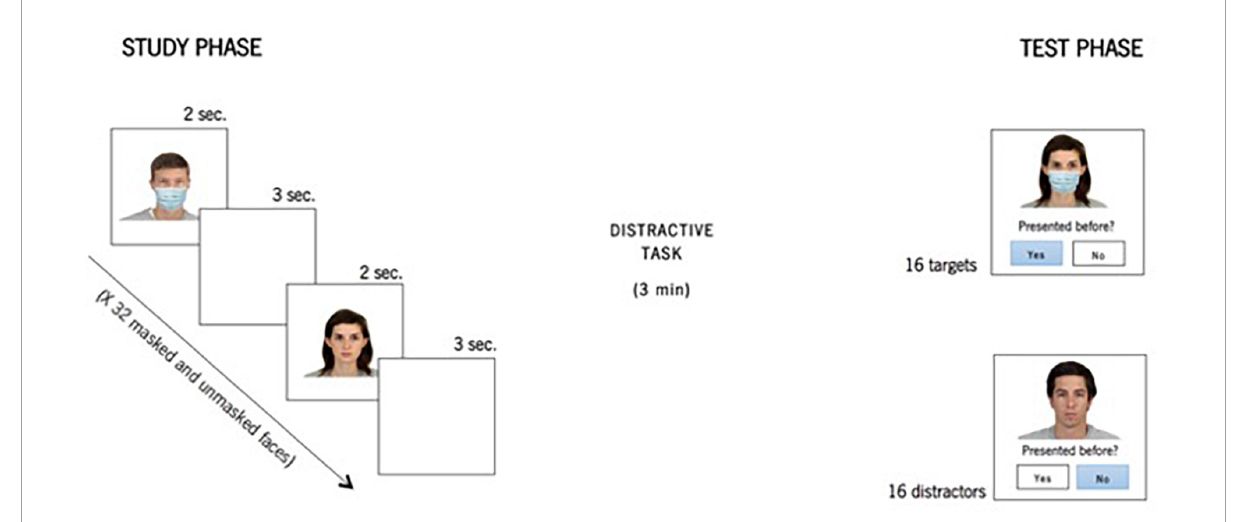
FIGURE2 Illustrative scheme of stimuli presented in the study and test phases. Reproduced with permission from the Chicago Face Database (Ma et al., 2015, p. 1125).